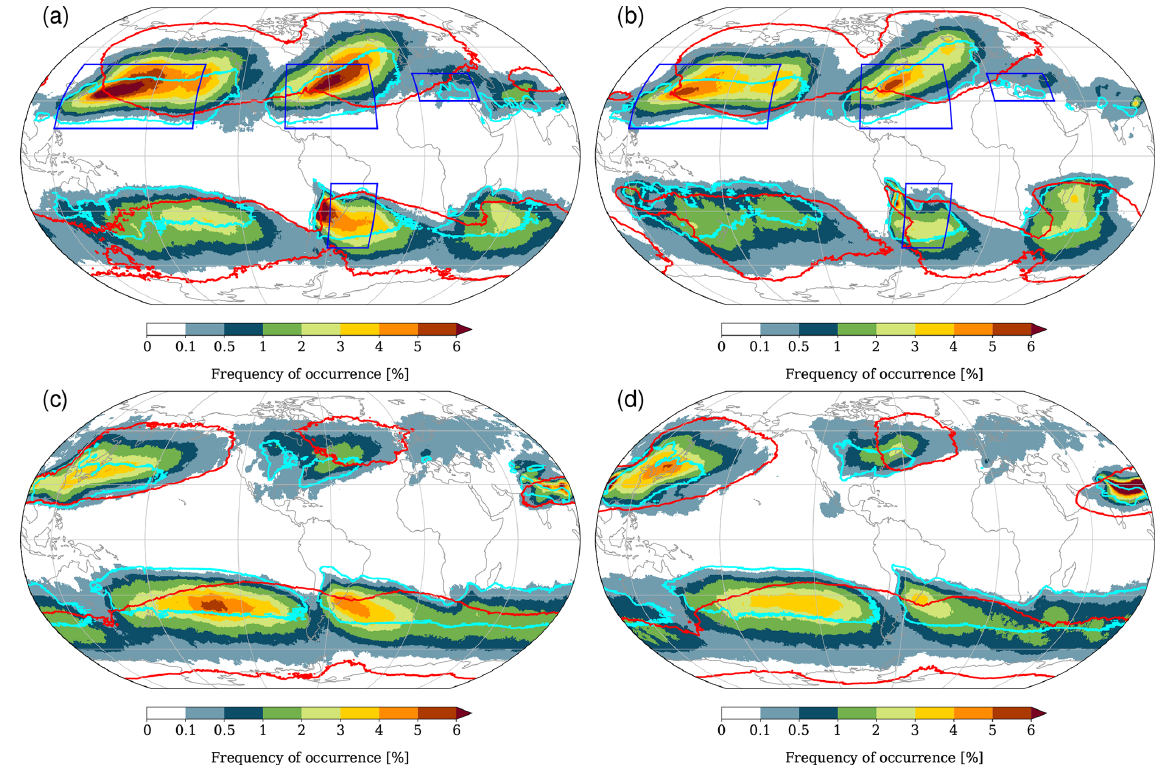
Figure 2. Climatological frequency of WCBs in December–January–February (DJF) (a, b) and June–July–August (JJA) (c, d) for ERA- Interim (a, c) and HIST (b, d) . Colours denote the percentage of 6-hourly time steps during which at least one WCB trajectory is located in a circle of 100km around the considered grid point, 24h after the start of the ascent. The turquoise line shows a frequency of 1% for WCBs at their starting time t = 0h, and the red line shows a frequency of 1% for WCBs at the end of their ascent at t = 48h. The blue boxes in panel (a) show the regions that are used for the regional analysis of WCBs in Figs.